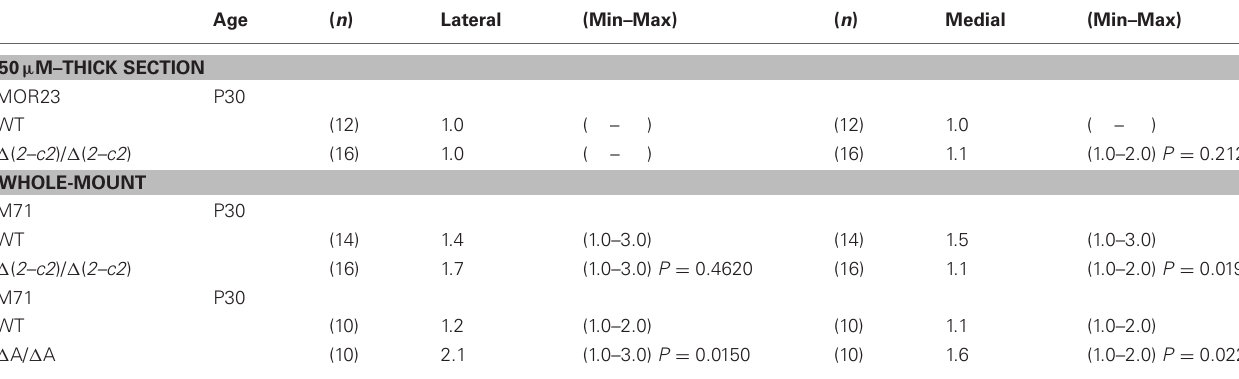
Table 2 | Number of glomeruli per half-bulb.